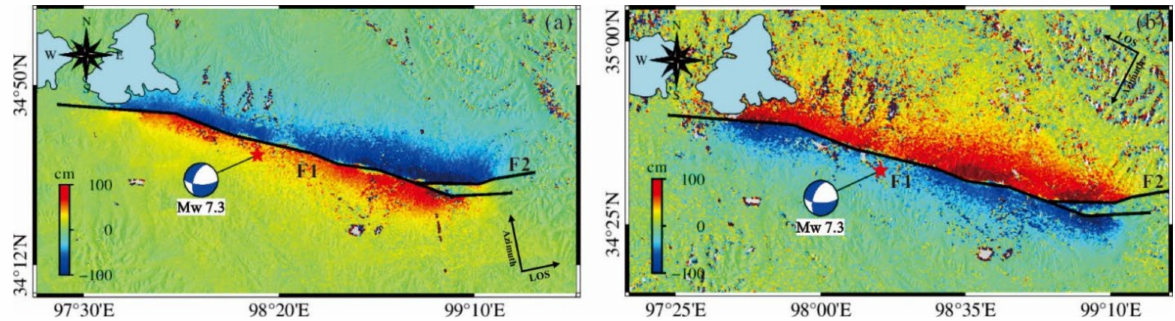
Figure 4. The extracted surface deformation along the satellite range direction (( a ) Sentinel-1 ascend- ing orbital track and ( b ) Sentinel-1 descending orbital track) of the 2021 Maduo earthquake based on the POT technique. The black lines denote the detected co-seismic fault surface trace, and the red star indicates the epicenter of the 2021 Maduo